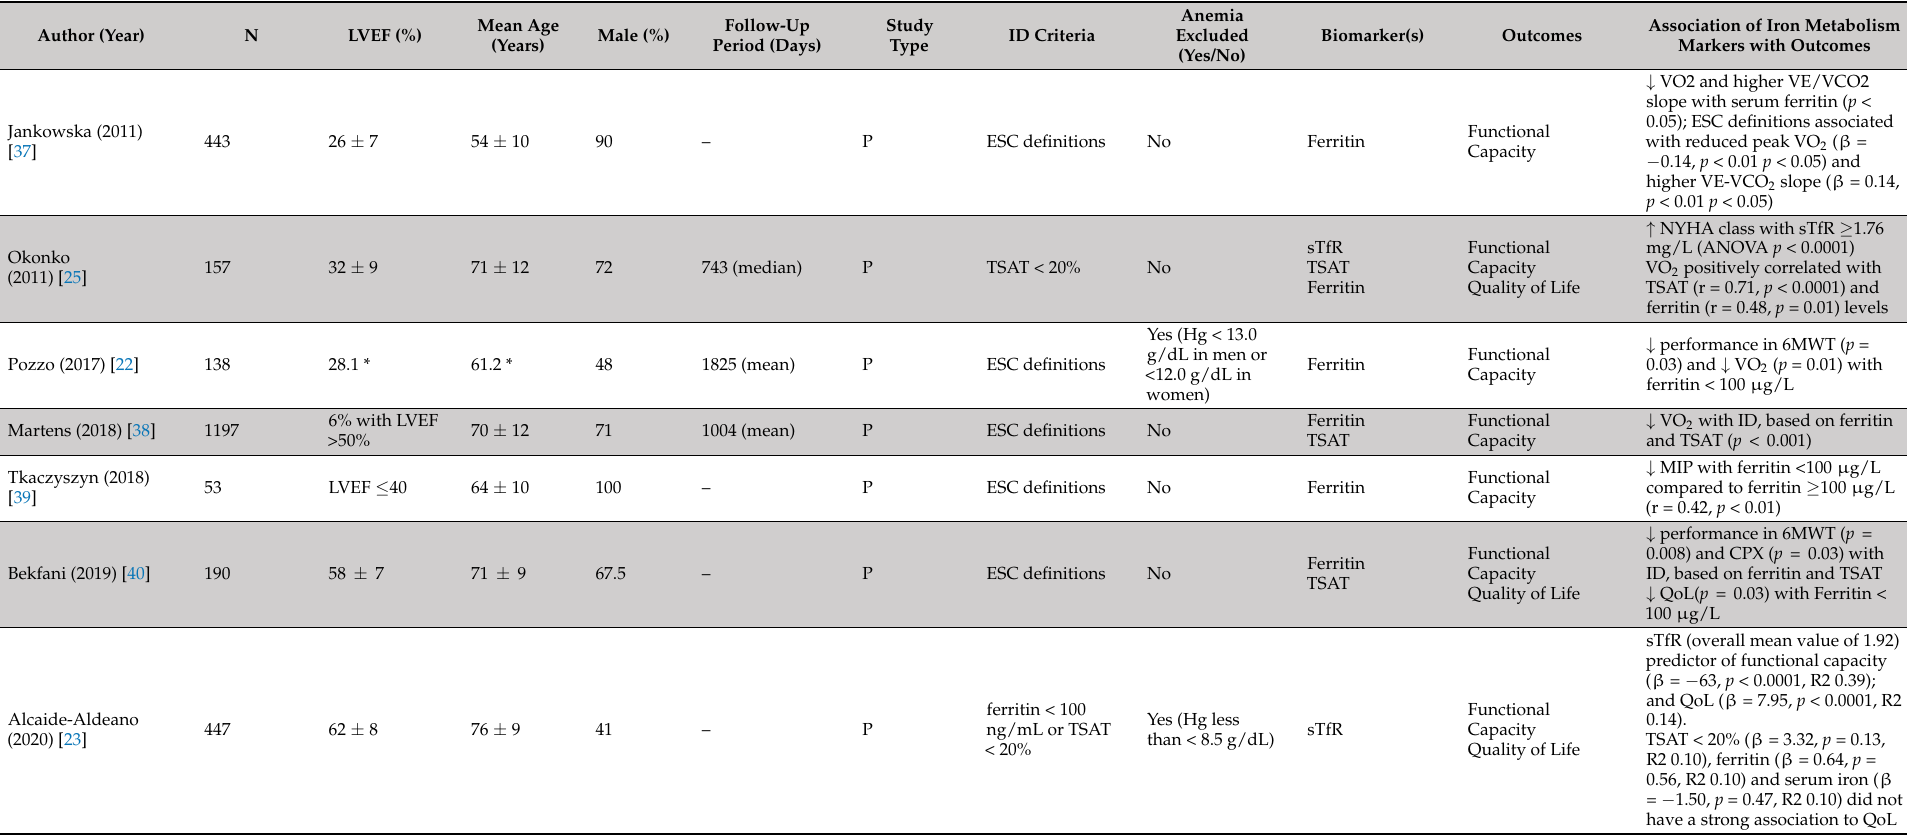
Table 3. Characteristics of Studies Associating Biomarkers of Iron Metabolism with Exercise/Functional Capacity and Quality of